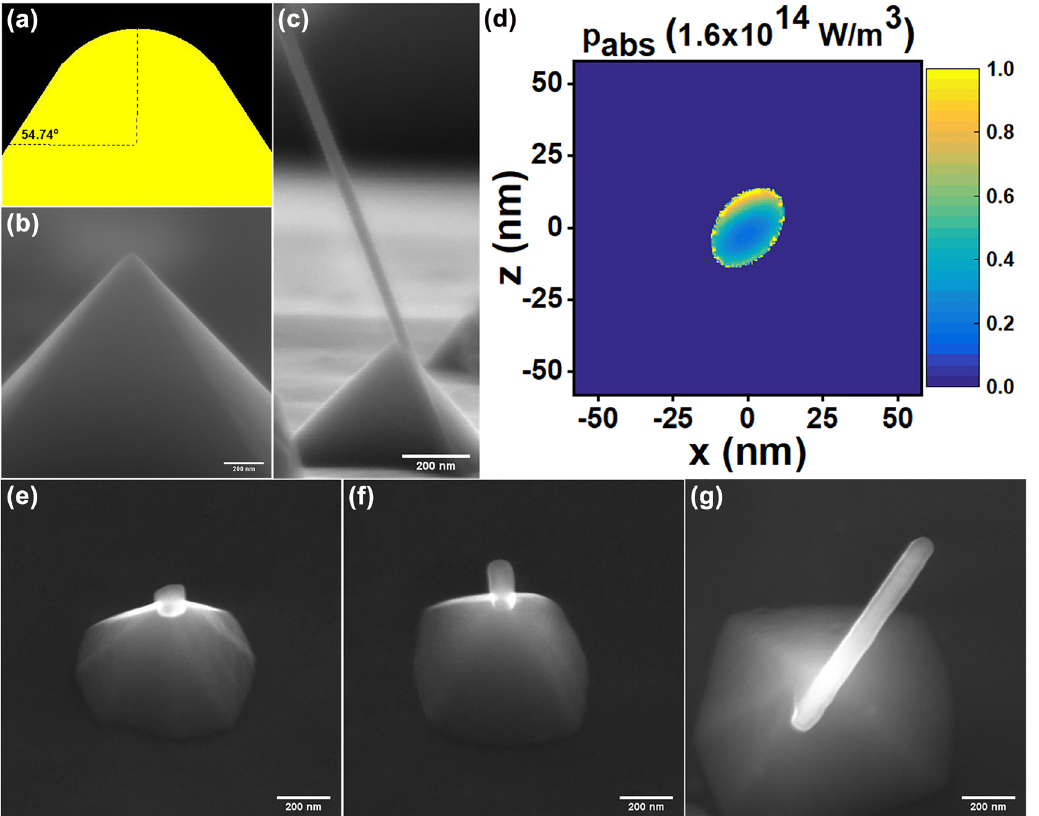
Figure 6: The effect of apex curvature and irradiation time on the grown nanotube of the CNT-tips. (a) Schematic of a tip apex, indicating the apex curvature and the slope of the lateral edge of the tip. (b) SEM image of a fabricated tip, indicating apex curvature with a diameter of about 36 nm. (c) Cross-sectional SEM image of a typical CNT-tip, including the grown CNT along the lateral edge of the pyramidal tip with the angle of 35.26 ◦ to the normal. (d) Heat generation density for an ellipsoidal Ni nanoparticle with a maximum tilt angle of 54.74 ◦ to the surface. The tilted profile inclines the growth of nanotube along the lateral edge of the tip. (e–g) CNT-tips for which the nanotubes are grown at different irradiation times of 15 s (e), 30 s (f), and 2.5 min (g) in the ONF-CVD